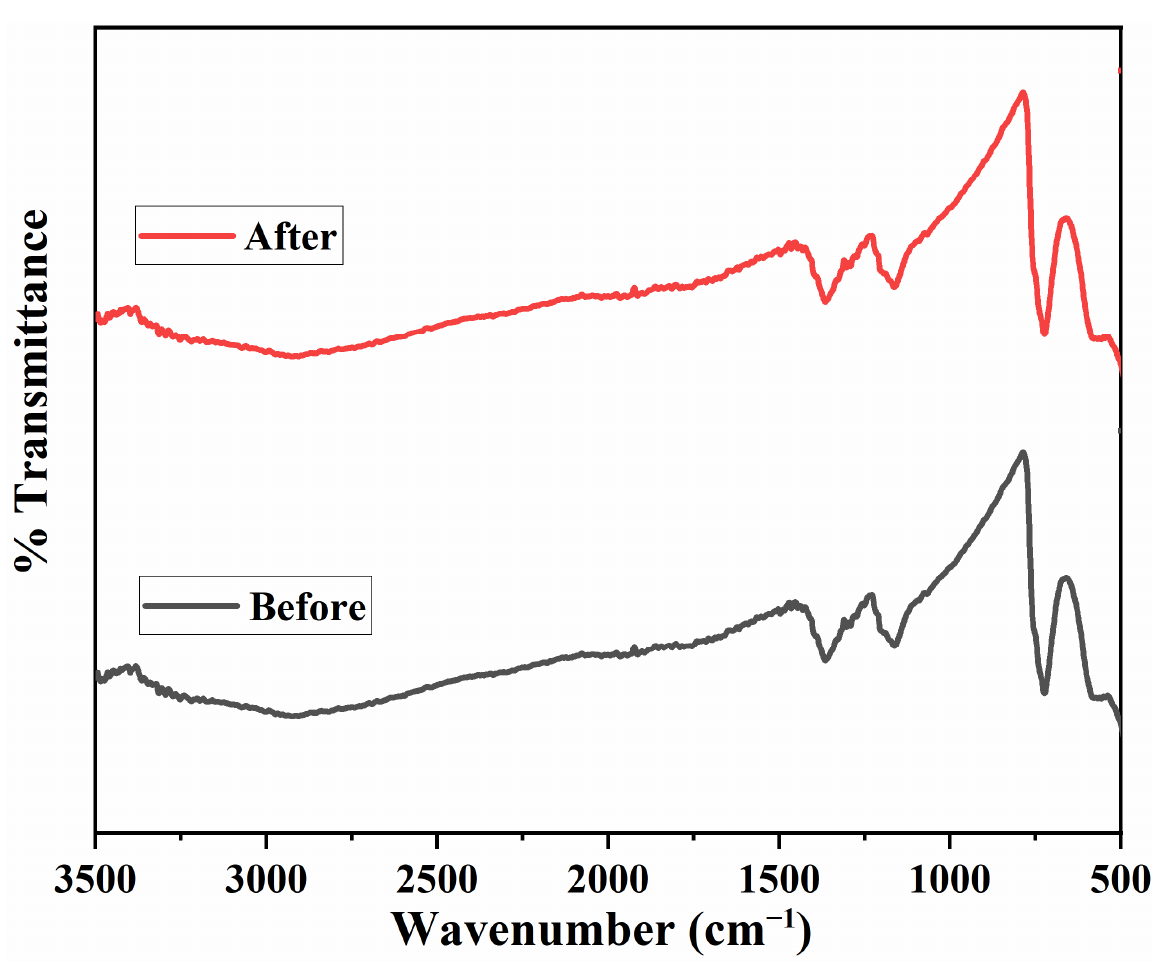
Figure 8. Structural stability test of the micro-spherical V 2 O 5 photocatalyst.